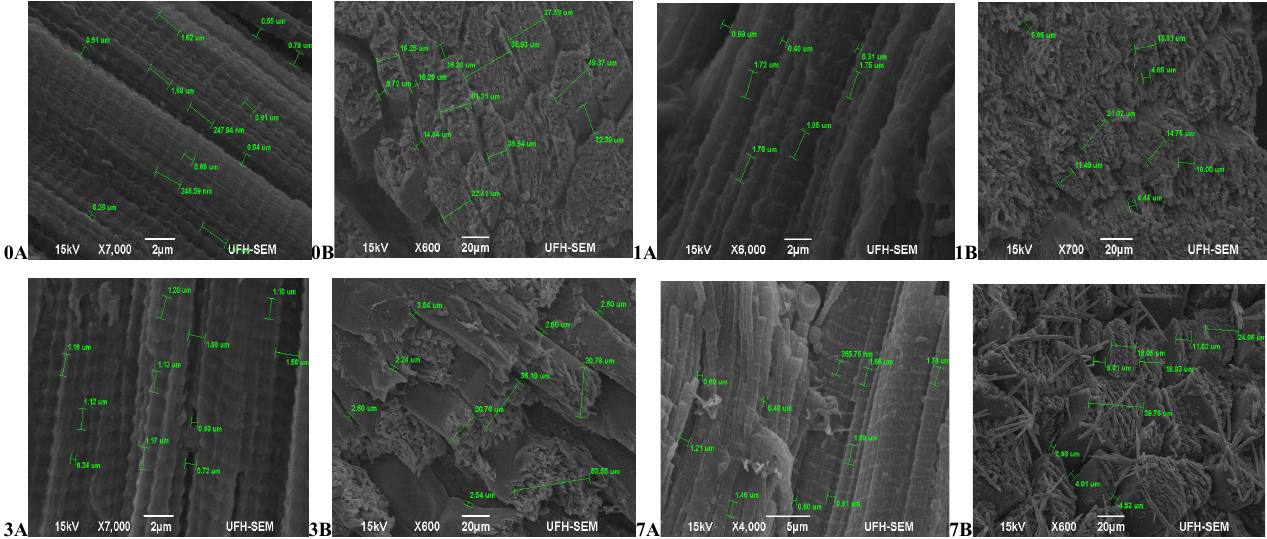
Figure 4. Transverse and Lateral muscle nanostructure changes of Simbra during a 7 day ageing period; observed under the JEOL JSM-6390LV scanning electron microscope (SEM) and further viewed using JEOL JM-5600 SEM at ×5,000 magnification. A, Lateral muscle structure from day 0, 1, 3, and 7 ageing period; B, transverse muscle structure from day 0, 1, 3, and 7 ageing period. μm, micrometre.